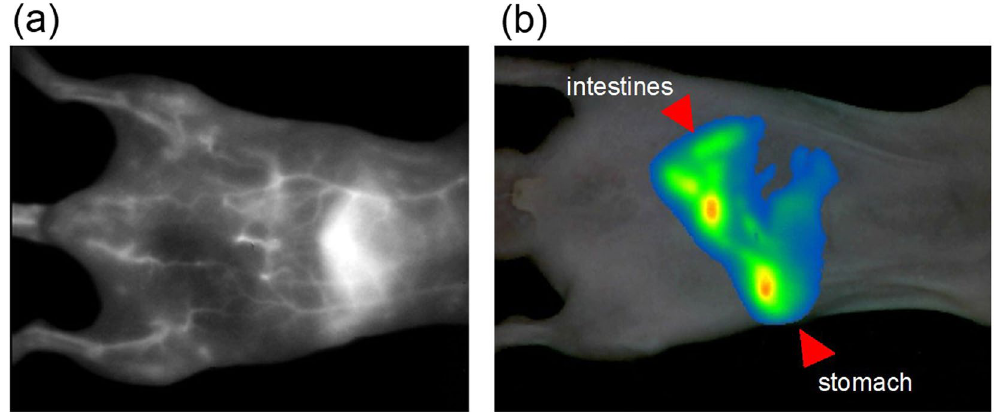
Figure 3. ( a ) NIR fluorescence image of mouse intravenously injected with o-SWCNTs. ( b ) Overlays of white light and NIR fluorescence images of mouse 5 min after oral administration of